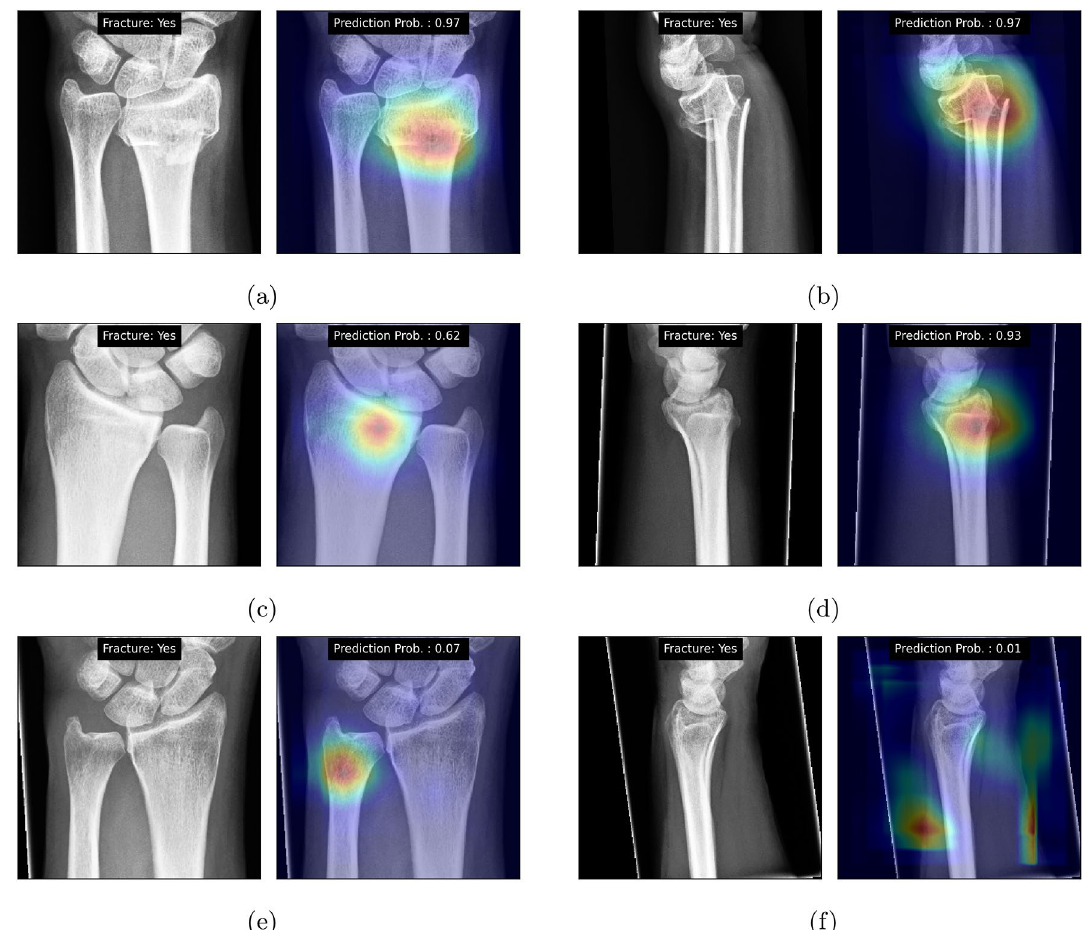
Figure 4. GradCAM-based heatmaps for the developed model. Each sub-figure shows input image and its label on the left side and GradCAM and prediction probability on the right side. ( a ) and ( b ) show PA and LAT views of a true positive case from test set #1 where the fracture is easily visible. ( c ) and ( d ) show both views of a true positive from test set #2 where the fracture is hardly visible and ( e ) and ( f ) show both views of a false negative case from test set #2 where the pipeline predicts them as